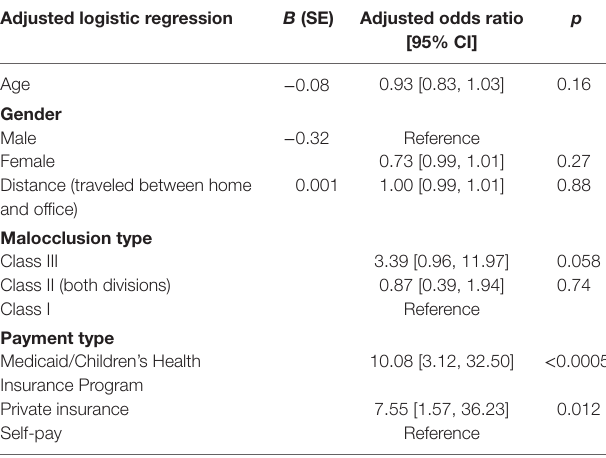
TaBle 1 | Logistic multivariate regression predicting treatment completion/